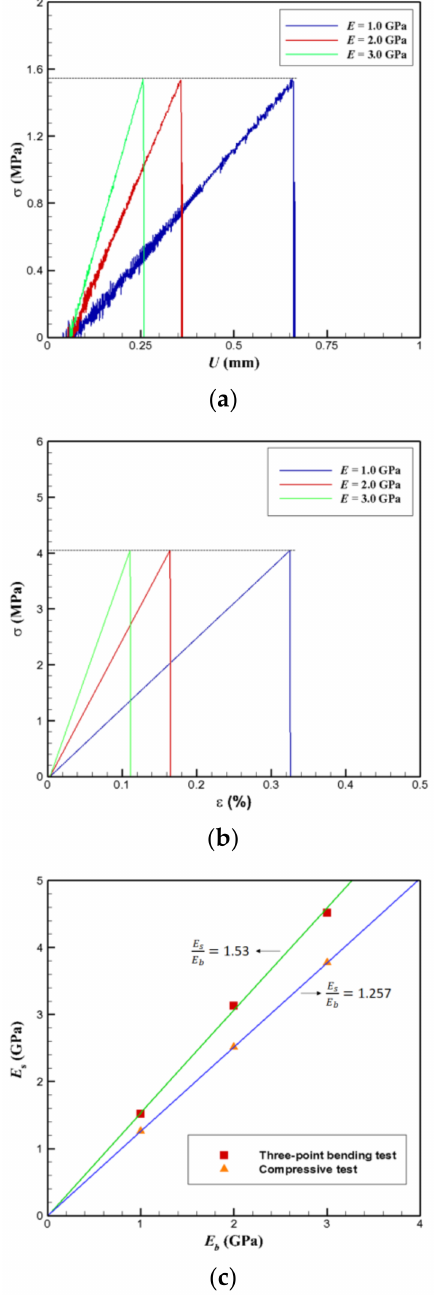
Figure 6. Effect of bond Young’s modulus: ( a ) stress–deflection curve; ( b ) stress–strain curve; ( c ) ratio of simulated Young’s modulus to bond Young’s